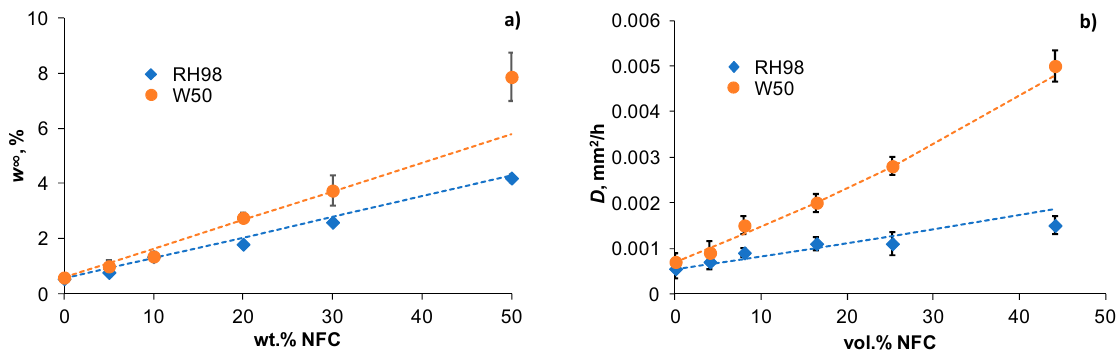
Figure 2. Equilibrium water content of PBS/NFC composites as a function of NFC weight content. Lines are approximations by Equation (4) ( a ); Diffusivity of PBS/NFC composites as a function of NFC volume content. Lines are approximations by Equation (5) ( b ).